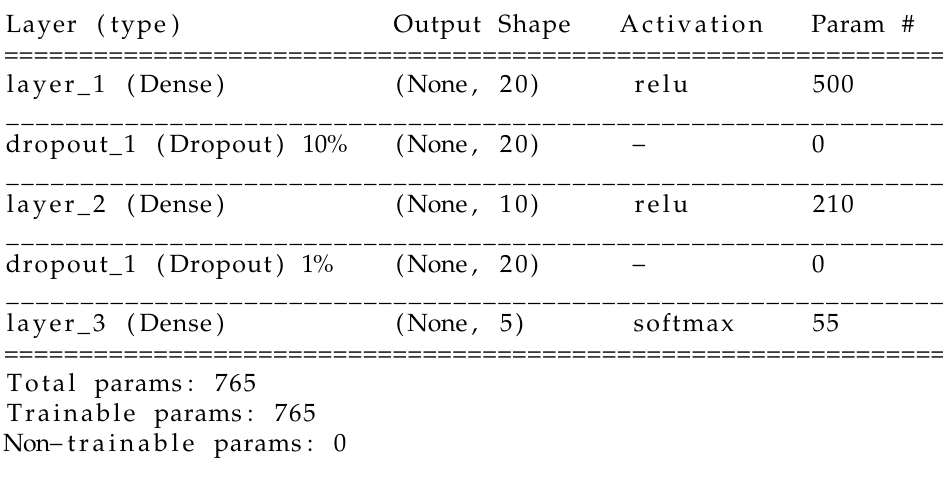
Figure 9. Summary of the DNN model proposed for biofuel classification for N c = 24 inputs of the layer